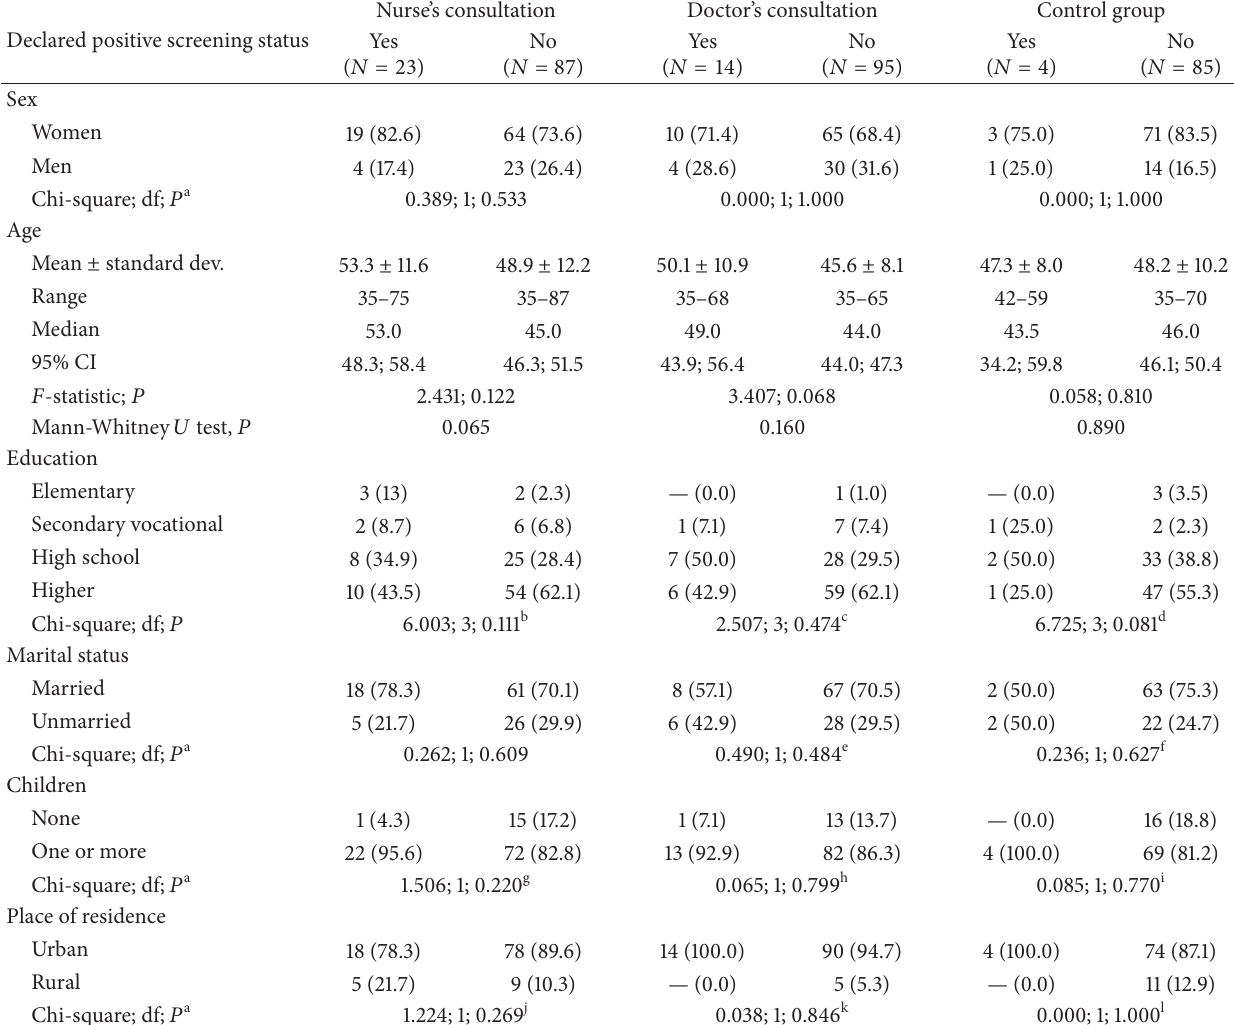
Table 3: Demographics of study participants according to their screening